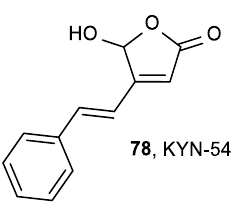
Figure 30. Butenolide KYN-54 ( 78 ) with antitumor activity.